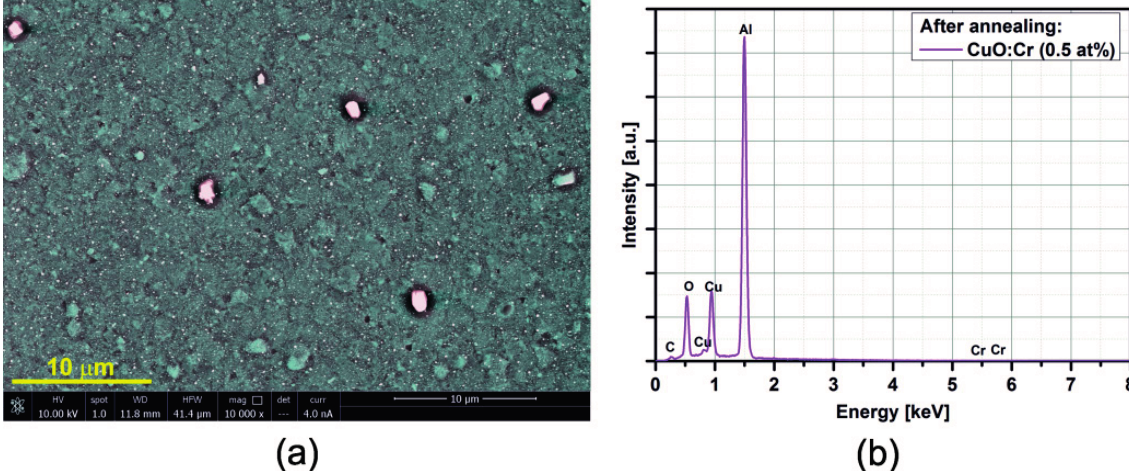
Figure 7. ( a ) SEM image; ( b ) EDX distribution of the Cr:CuO-based sensor (Cr: